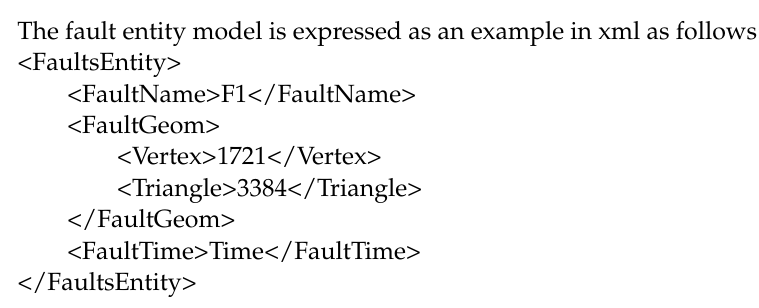
Figure 13. Diagram of XML structure of fault entity.